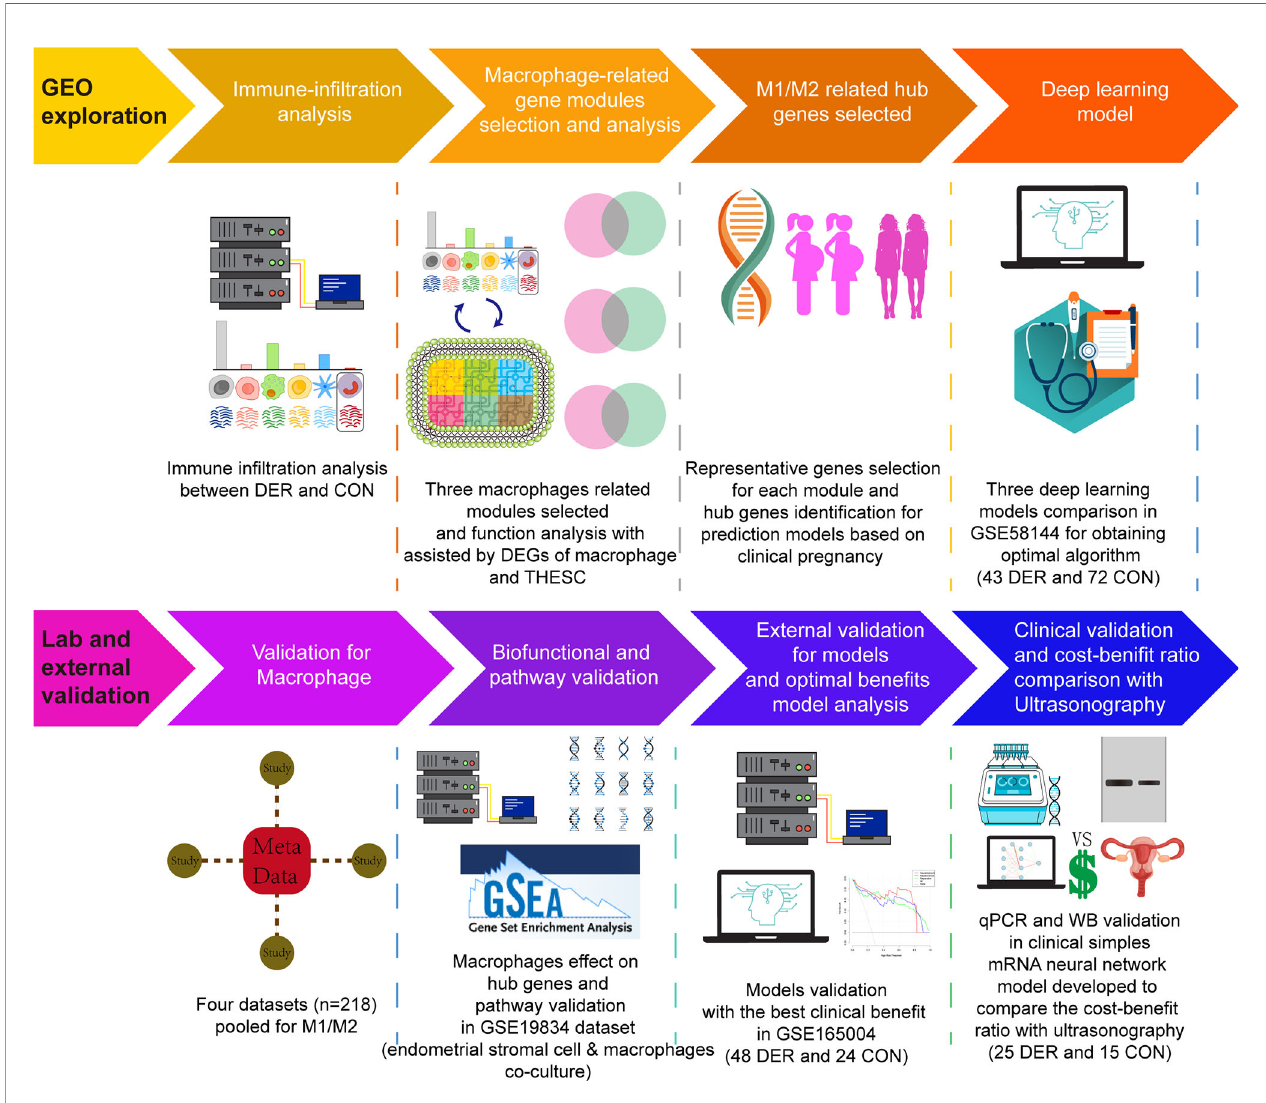
FIGURE 1 | Schematic presentation of the study design. DER, defective endometrial